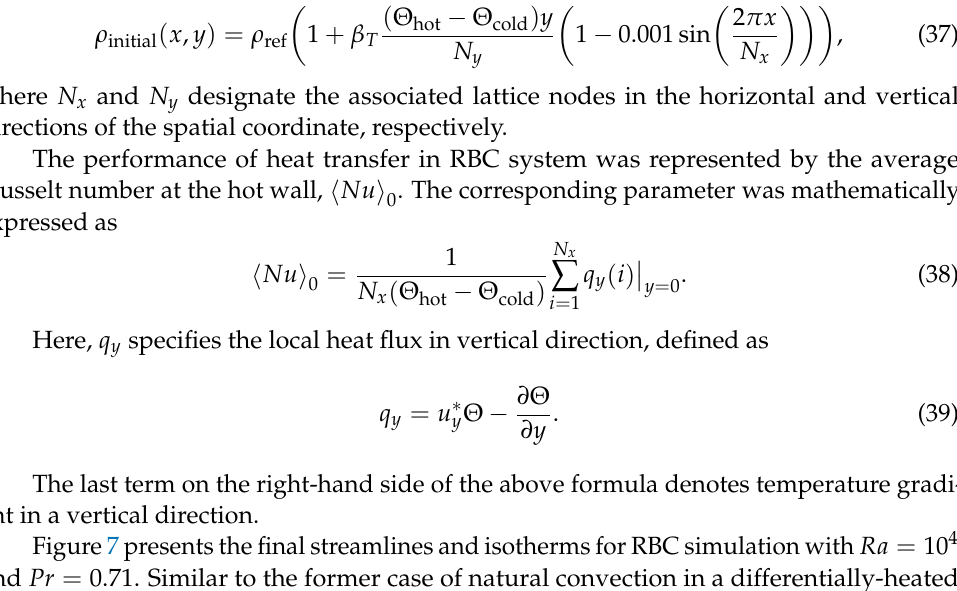
of the Rayleigh-B è nard convection sys- 0